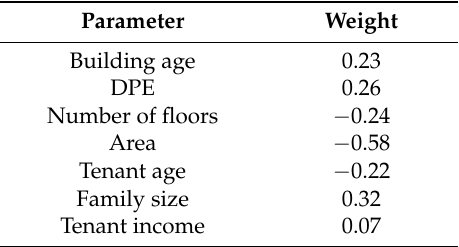
Table 4. Weight of the indicators in the heating expenses.